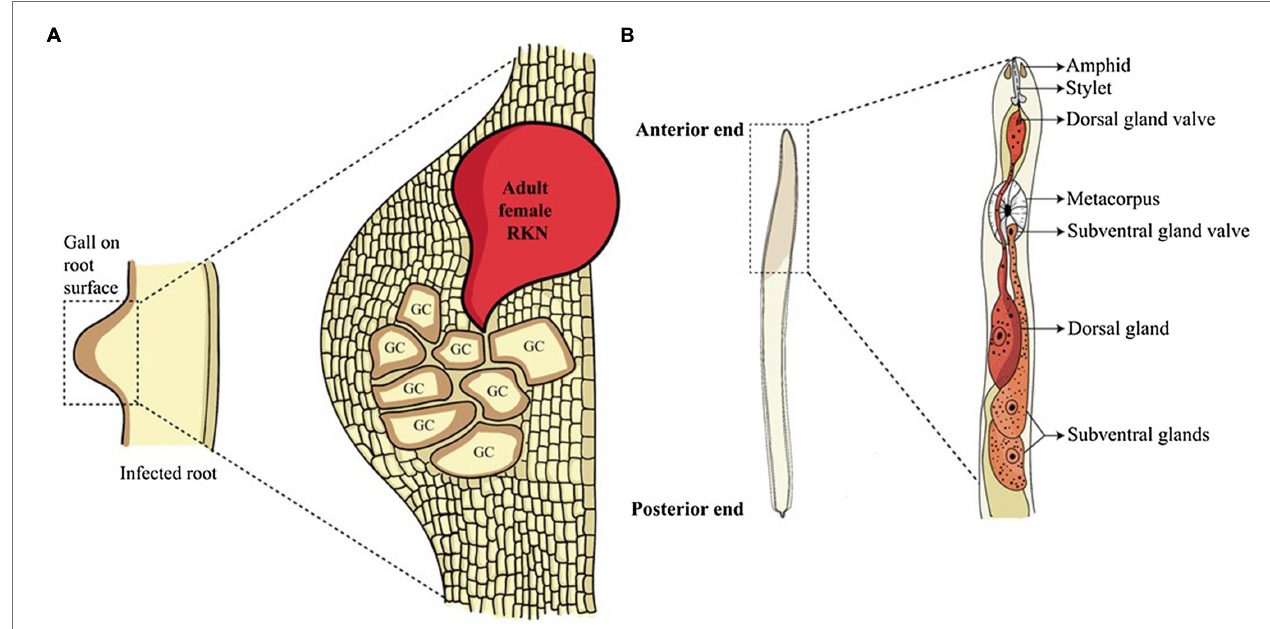
FIGURE 1 | Root-knot nematode infection and glands involved in effector synthesis. (A) Root-knot nematode infected roots show a gall-like structure on the root surface. Inside the gall, adult sedentary nematodes reside. These adults secrete a large number of effectors in the plant cells converting them into multinucleated GCs, the feeding sites of nematodes. (B) The anatomy of the anterior structure of pre-parasitic juvenile RKN shows two main oesophageal glands. The oesophageal glands, namely sub-ventral glands (SvGs) and dorsal gland (DG) are the primary sites of effector production in nematodes. The effectors produced by these glands are secreted through the stylet into the plant